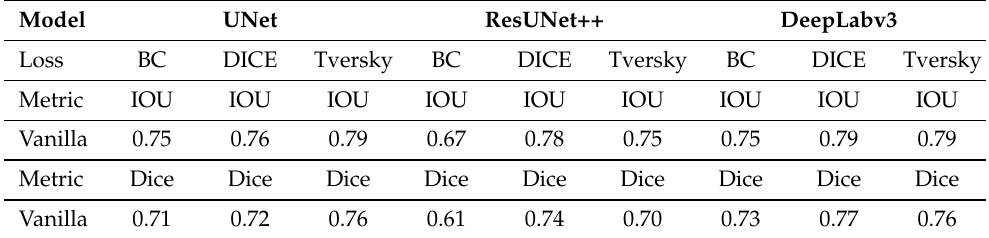
Table 6. The performance according to loss functions in basic Ultrasound dataset.